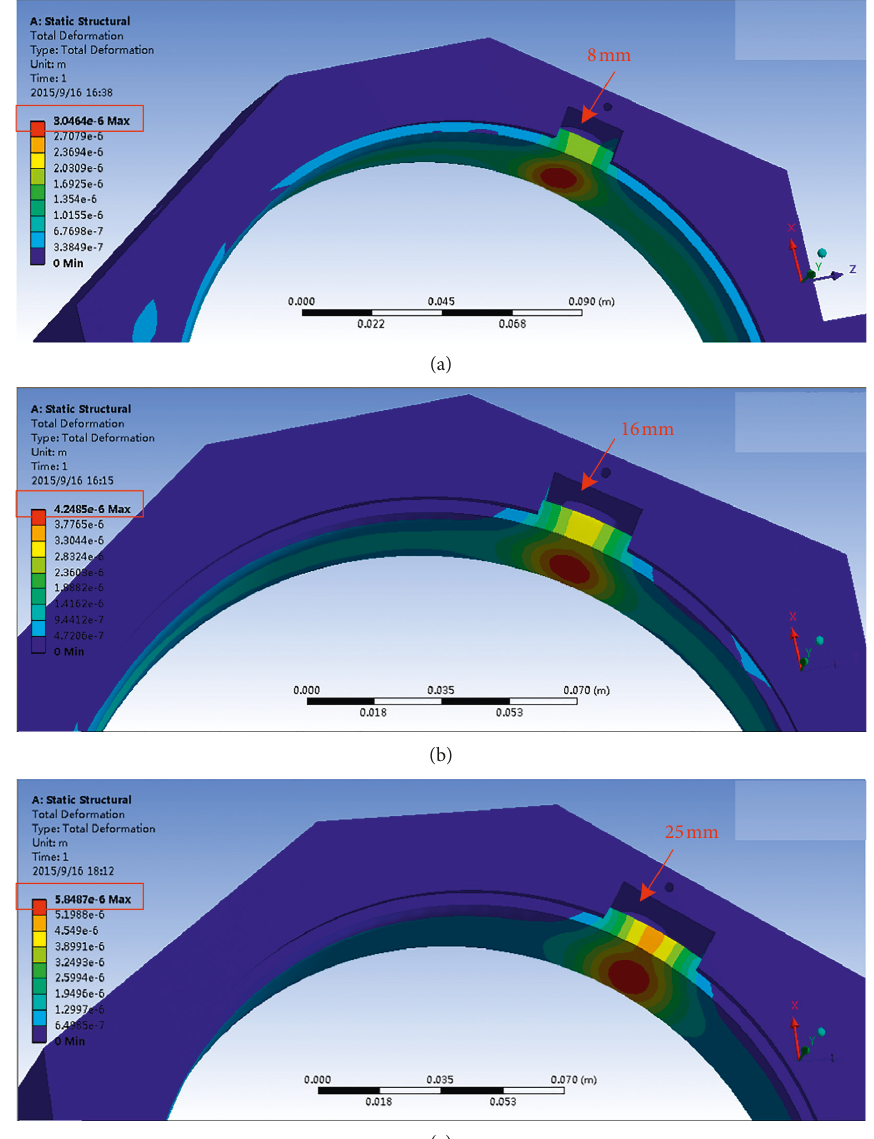
Figure 7: Ascertain the size of D